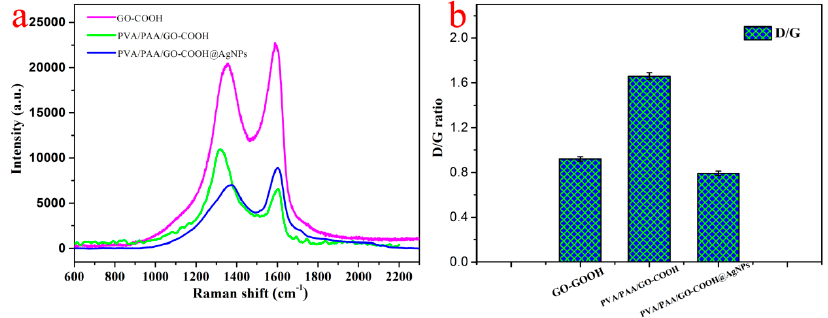
Figure 5. Raman spectroscopy ( a ) and D/G ratios ( b ) of different samples.